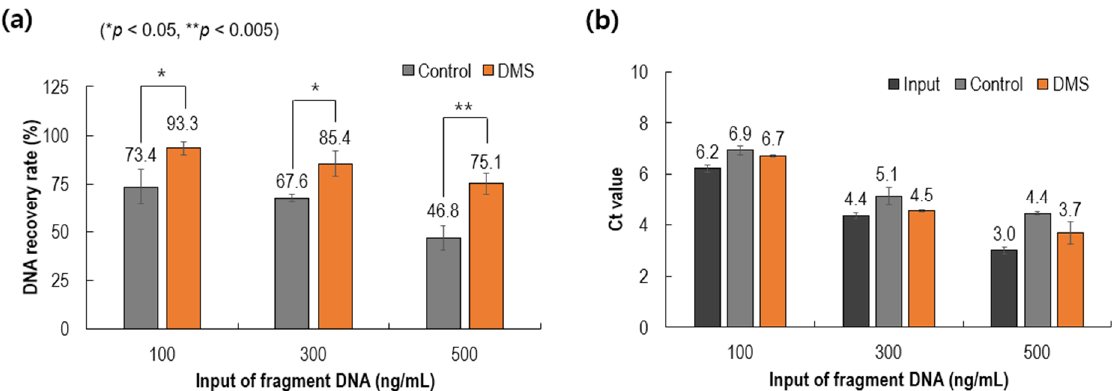
Figure 5. Performance analysis of cfDNA extraction. ( a ) DNA recovery rates according to input of fragment DNA. ( b ) Threshold cycles for the spiked DNA according to input of fragment DNA. Control: QIAamp (Qiagen).